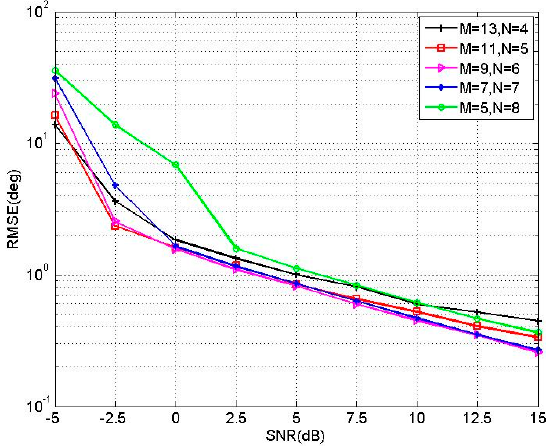
Figure 4. RMSE of different M and N versus SNR.